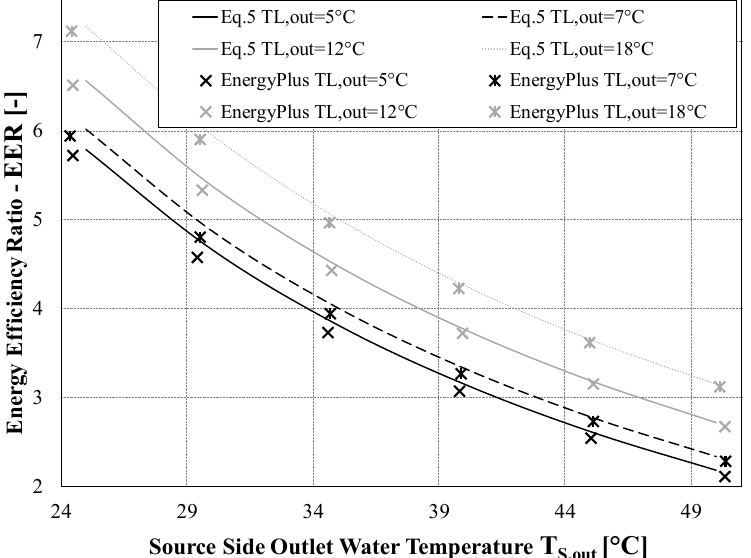
Figure 6. EER in cooling mode: comparison between EnergyPlus simulations and equation fit model approach.